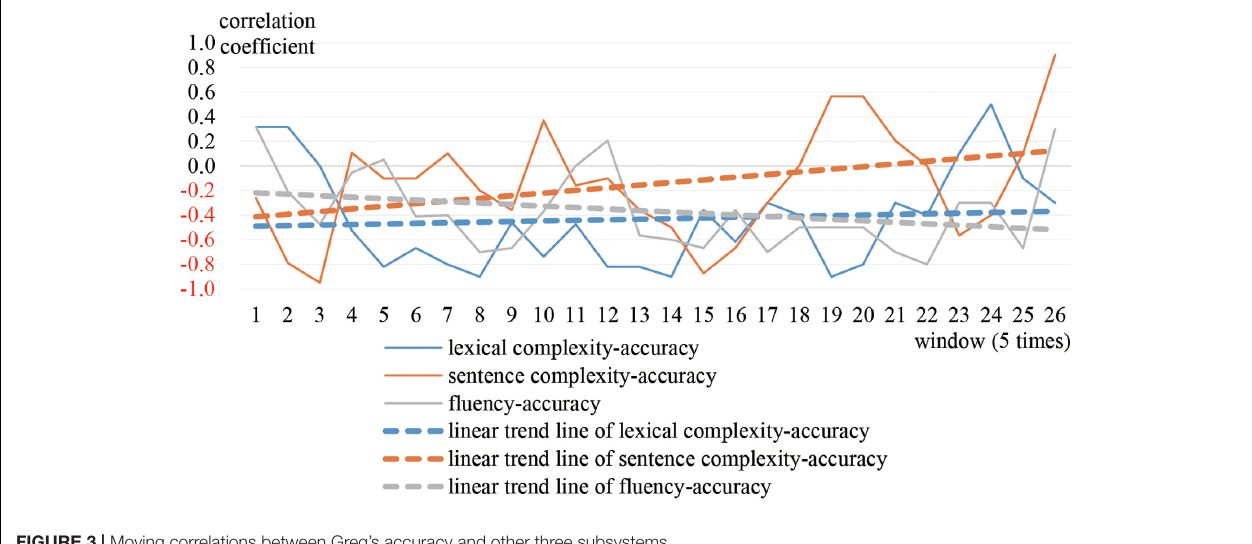
FIGURE 3 | Moving correlations between Greg’s accuracy and other three subsystems.